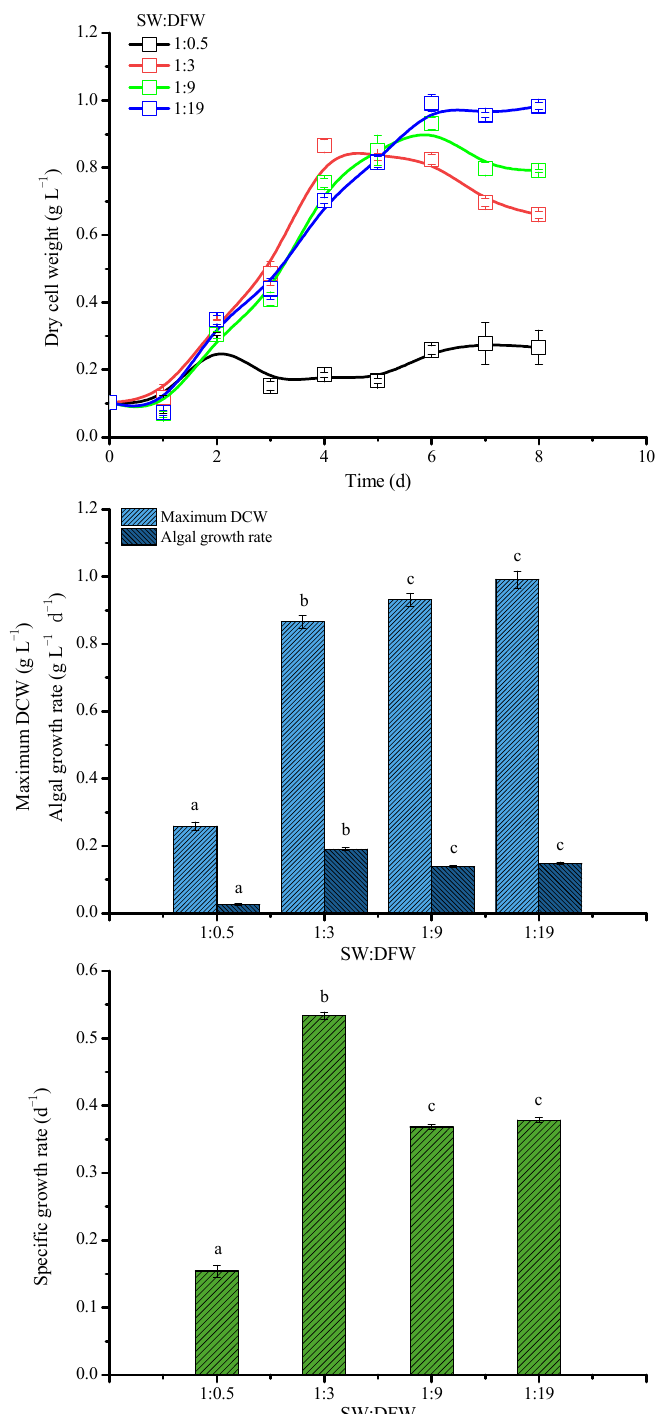
Figure 1. Growth performance of C. pyrenoidosa cultured in the mixed wastewater of swine wastewater (SW) and diluted furfural wastewater (DFW) with different proportions. Data are shown as mean ± SD, n = 3. Different letters in the same column represent significant differences ( p ≤ 0.05).